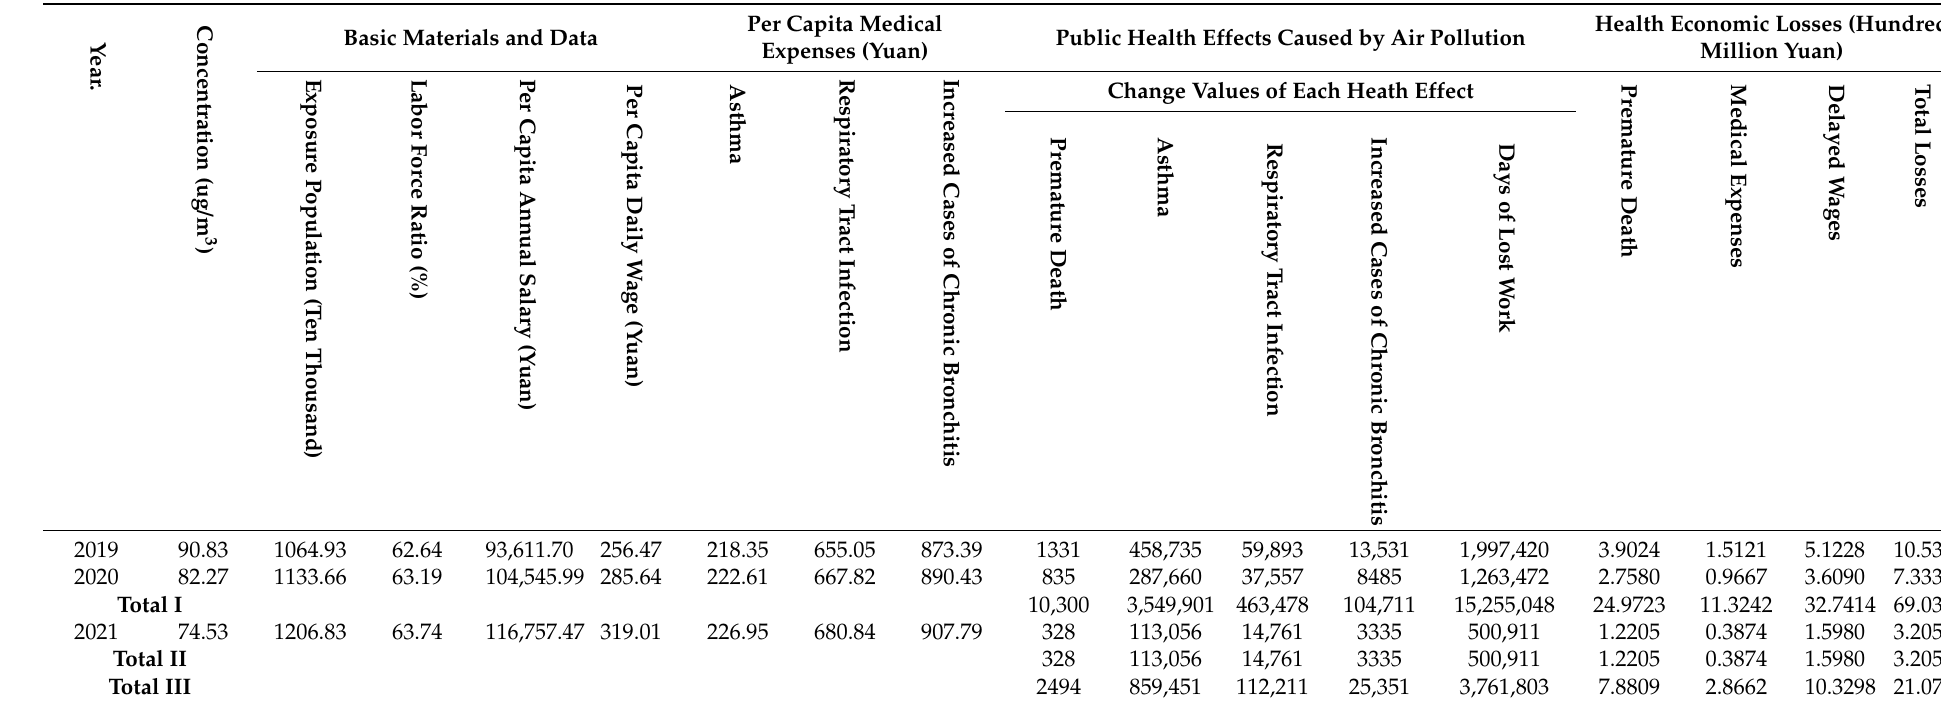
Table 8. Results of the public health effects caused by air pollution and the corresponding economic losses from 2019 to 2021.